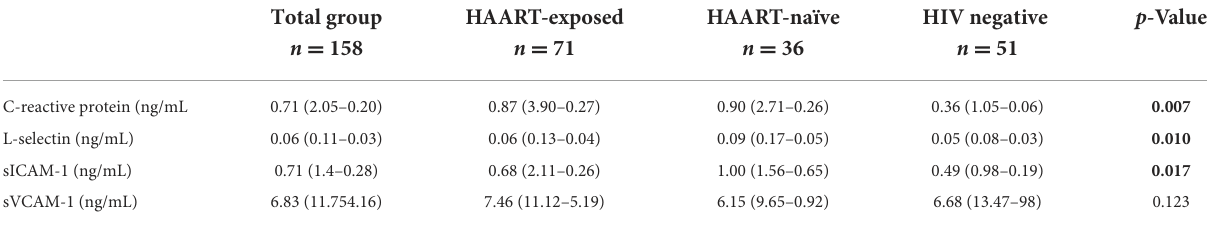
TABLE 4 Biomarkers of the study